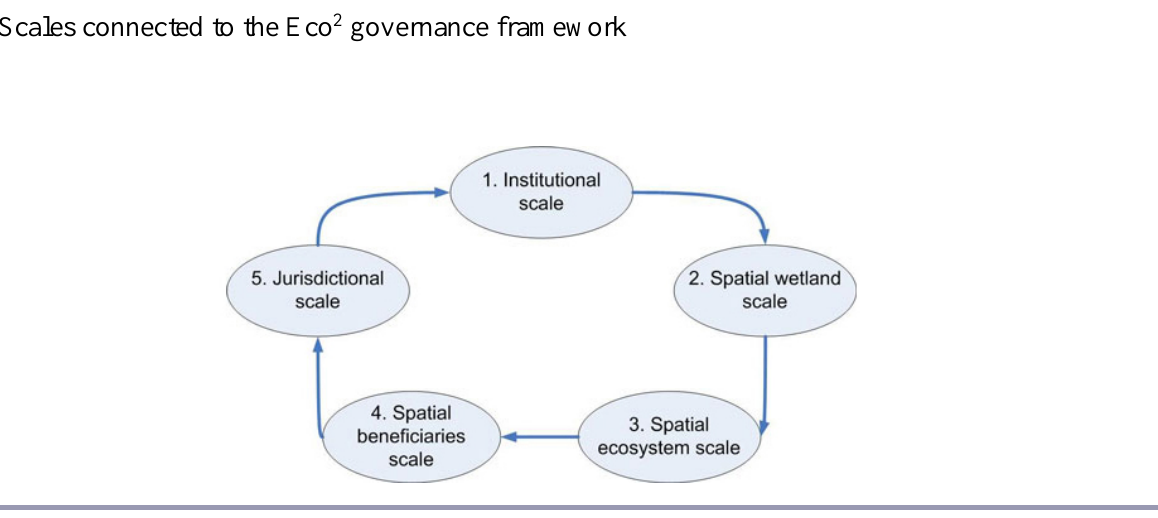
Fig. 3. Scales connected to the Eco 2 governance